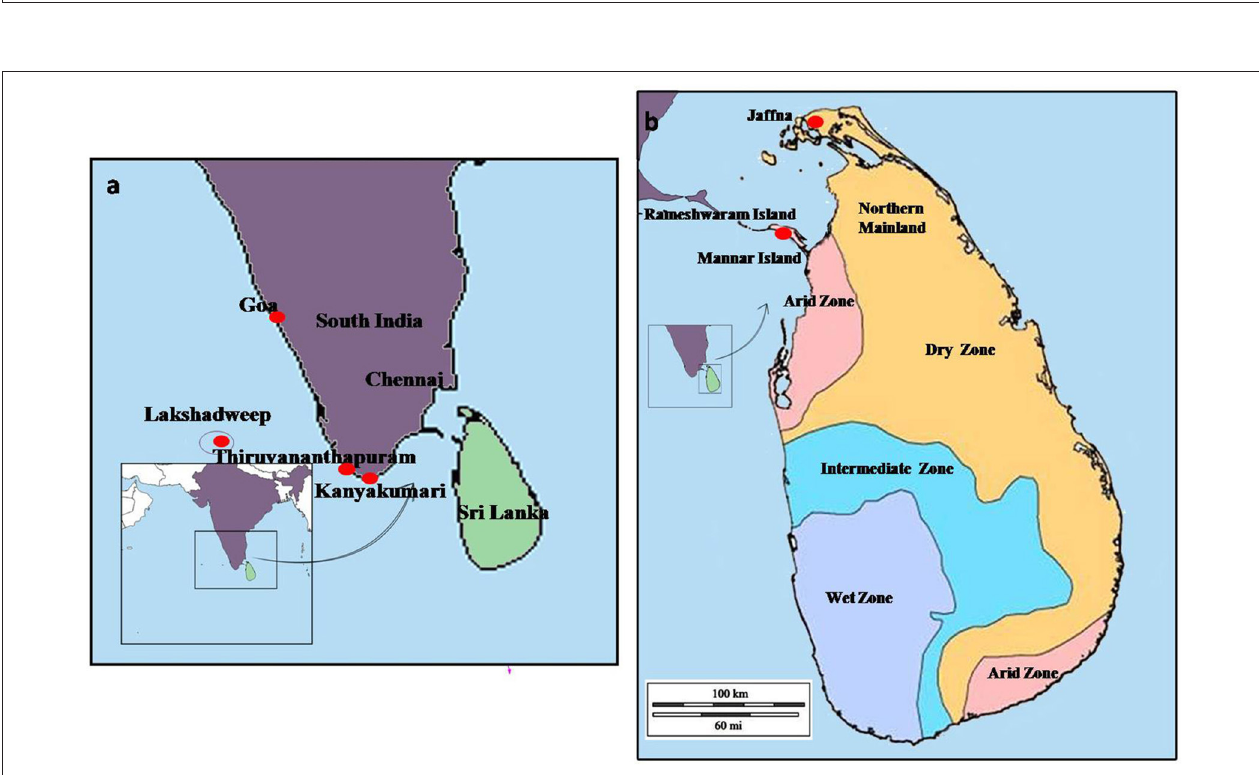
Frontiers in Public Health | www.frontiersin.org